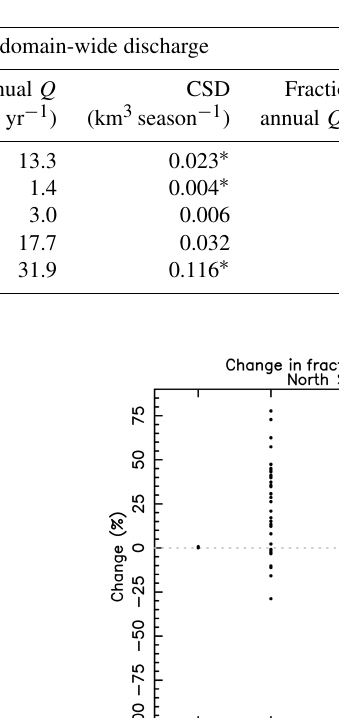
Table 2. River basin area, annual discharge ( Q ), and cold season discharge (CSD) for the Colville, Kuparuk, and Sagavanirktok rivers and the full North Slope domain. River basins with a significant increase in CSD are indicated with a superscript ∗ . Basin areas are based on the gridded 25km simulated topological river network.